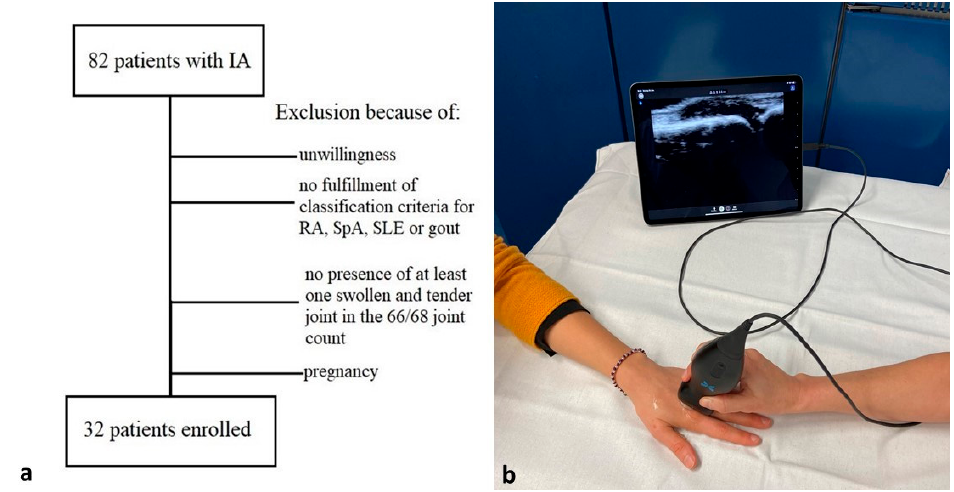
Figure 1. Study flowchart and used handheld US equipment. Depiction of recruitment flowchart ( a ) and the handheld portable US device Butterfly iQ ( b ), which was directly connected to a tablet.